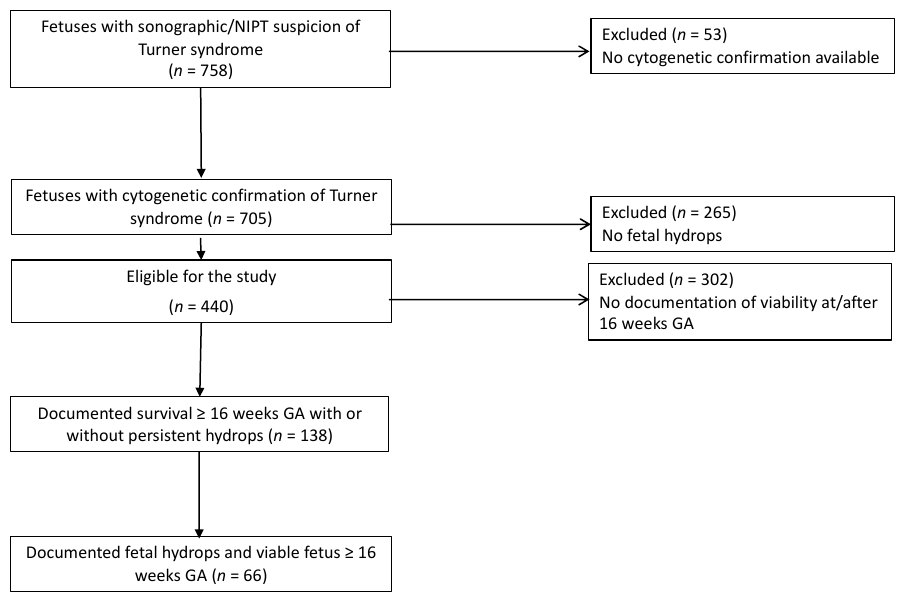
Figure 1. Selection of study cohort. Table 1. Demographic and clinical characteristics of the study population.